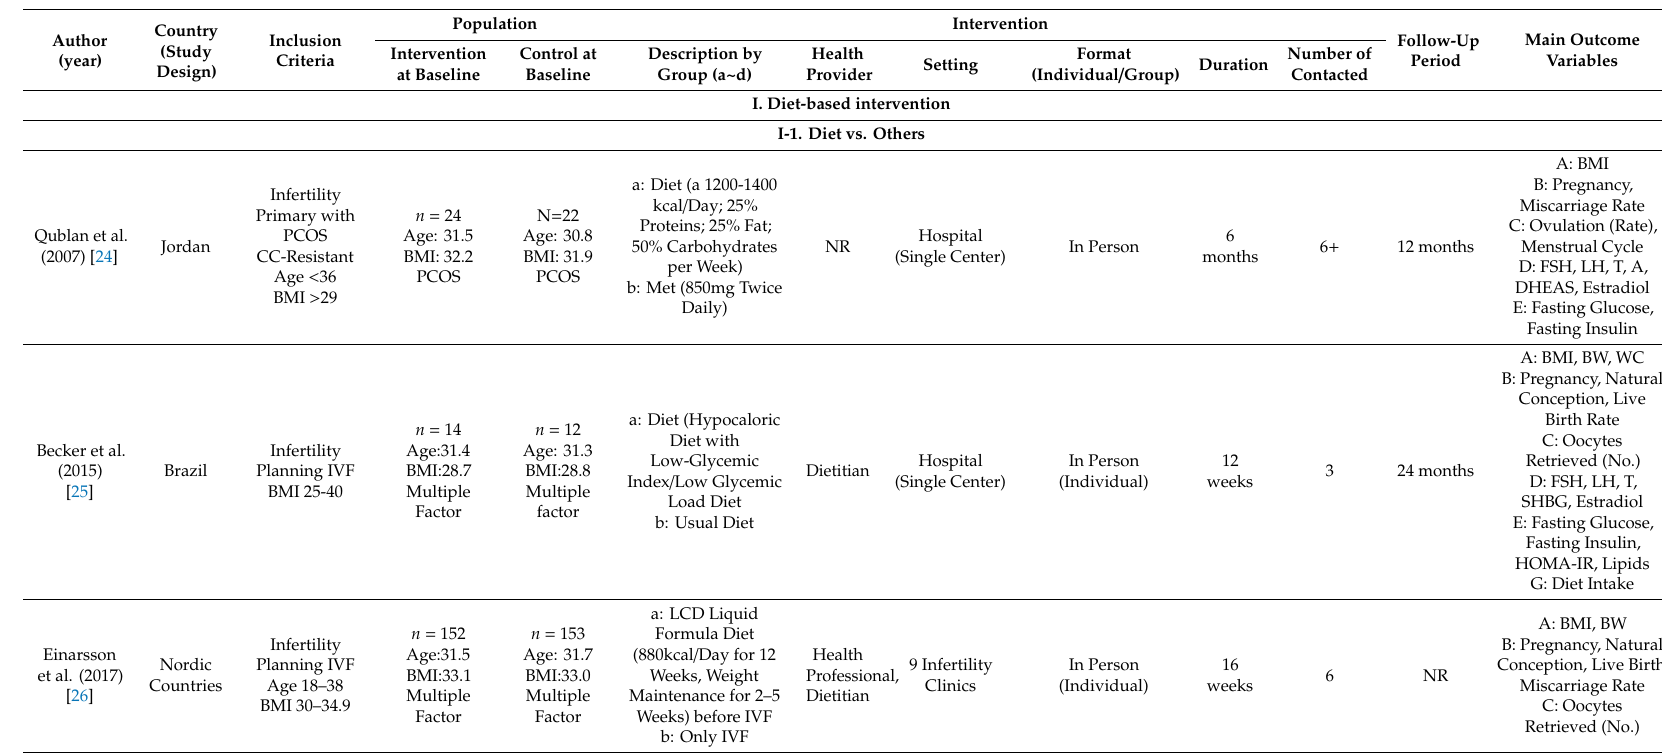
Table 1. Descriptive summary of included studies ( N =